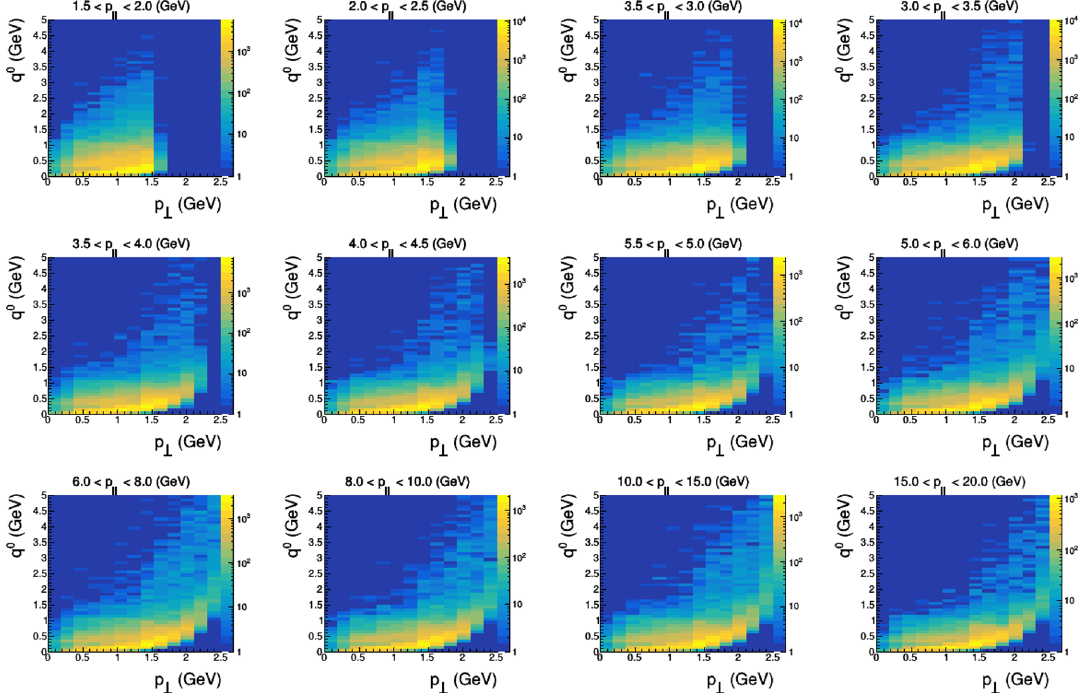
bins as in figure 6. The color k